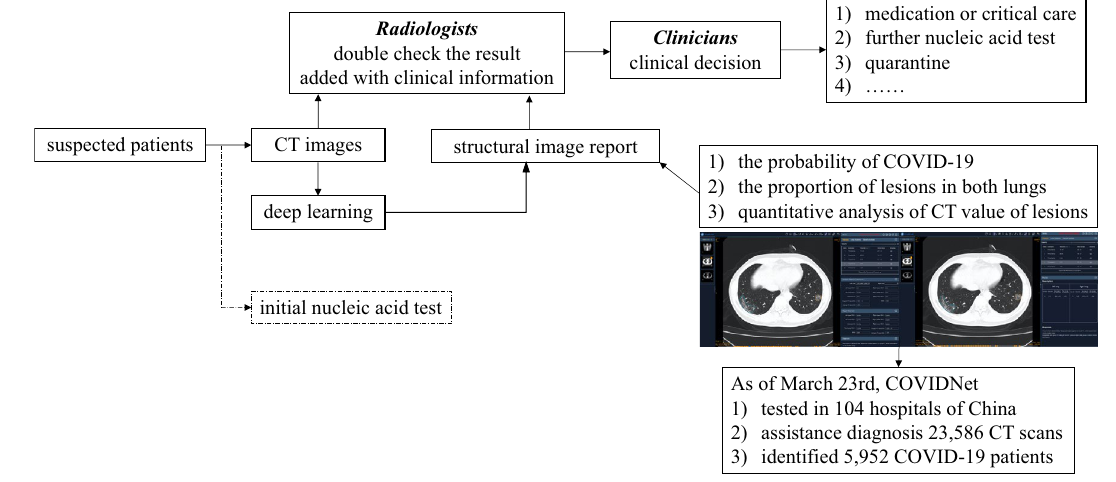
Figure 3. The pipeline of COVIDNet application in the real world.